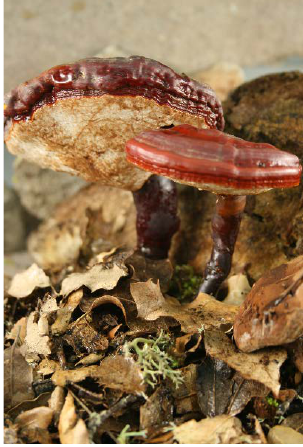
Figure 1. Ganoderma lucidum at the base of Quercus coccifera in Spain, Castellón, El Toro, 19 November, 2008, Mir and Atienza, Herbarium VAL-Myco 134. Table 1. Common name of Ganoderma lucidum in several languages, adapted from [3].